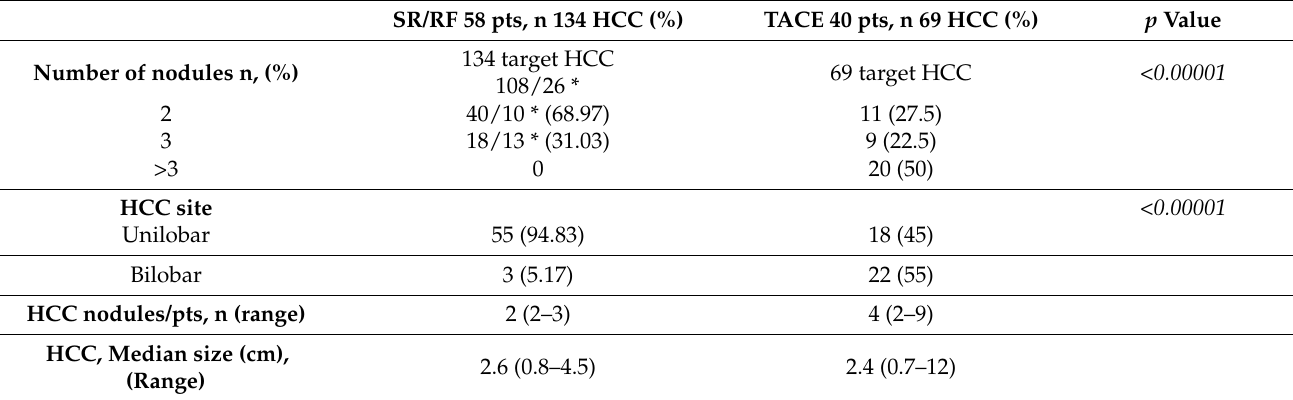
Table 5. Tumor features in BCLC-B patients treated with SR or TACE.